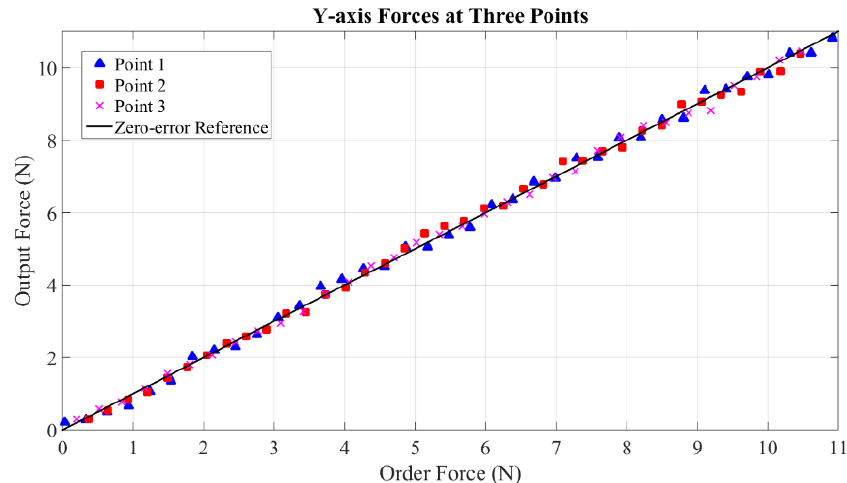
Figure 19. Forces at three points along Y-axis.